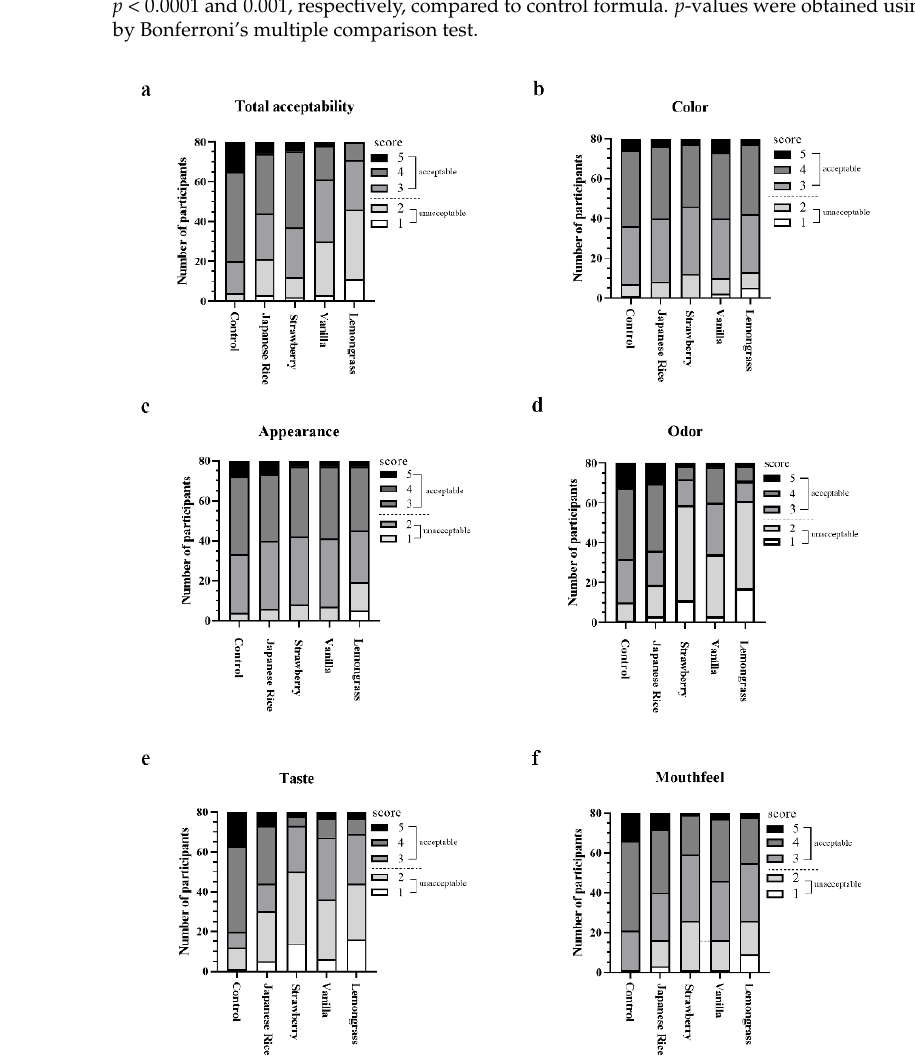
Table 5. Sensory satisfaction scores for the control and various flavor-fortified formulas.